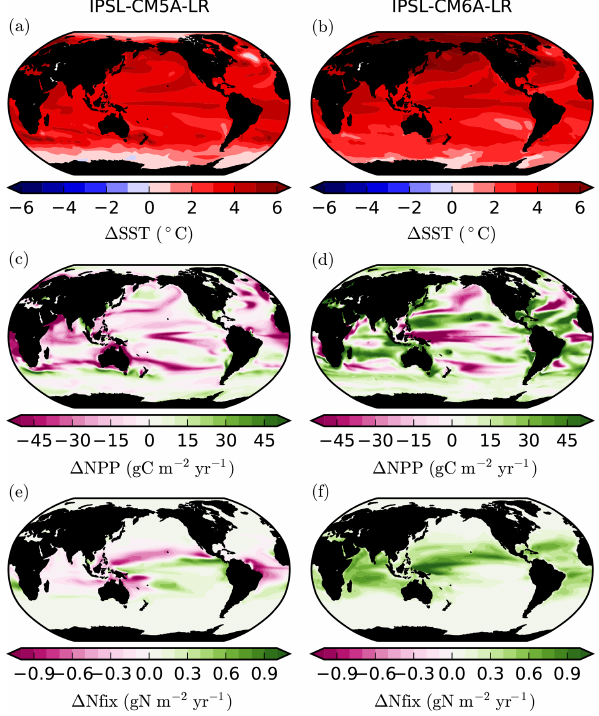
Figure 3. Changes in (a, b) sea surface temperature (SST, ◦ C), (c, d) vertically integrated net primary production (NPP, gCm − 2 yr − 1 ) and (e, f) vertically integrated N fixation (Nfix, gNm − 2 y − 1 ) between 1986–2005 and 2081–2100. Panels (a) , (c) and (e) are for IPSL-CM5A under RCP8.5, whereas (b) , (d) and (f) are for IPSL-CM6A under